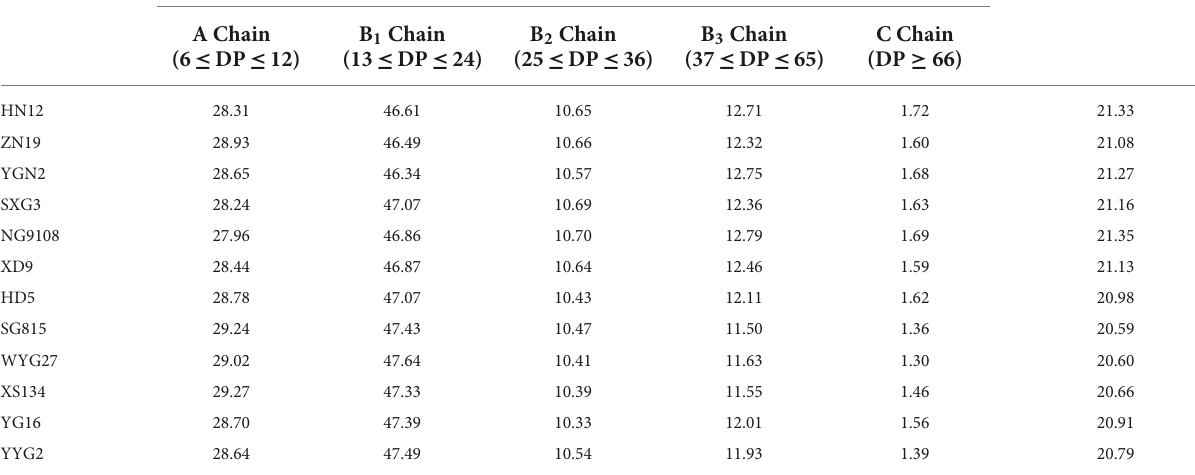
TABLE 2 Chain length distribution (CLD) analysis of debranched rice starches extracted from japonica rice.